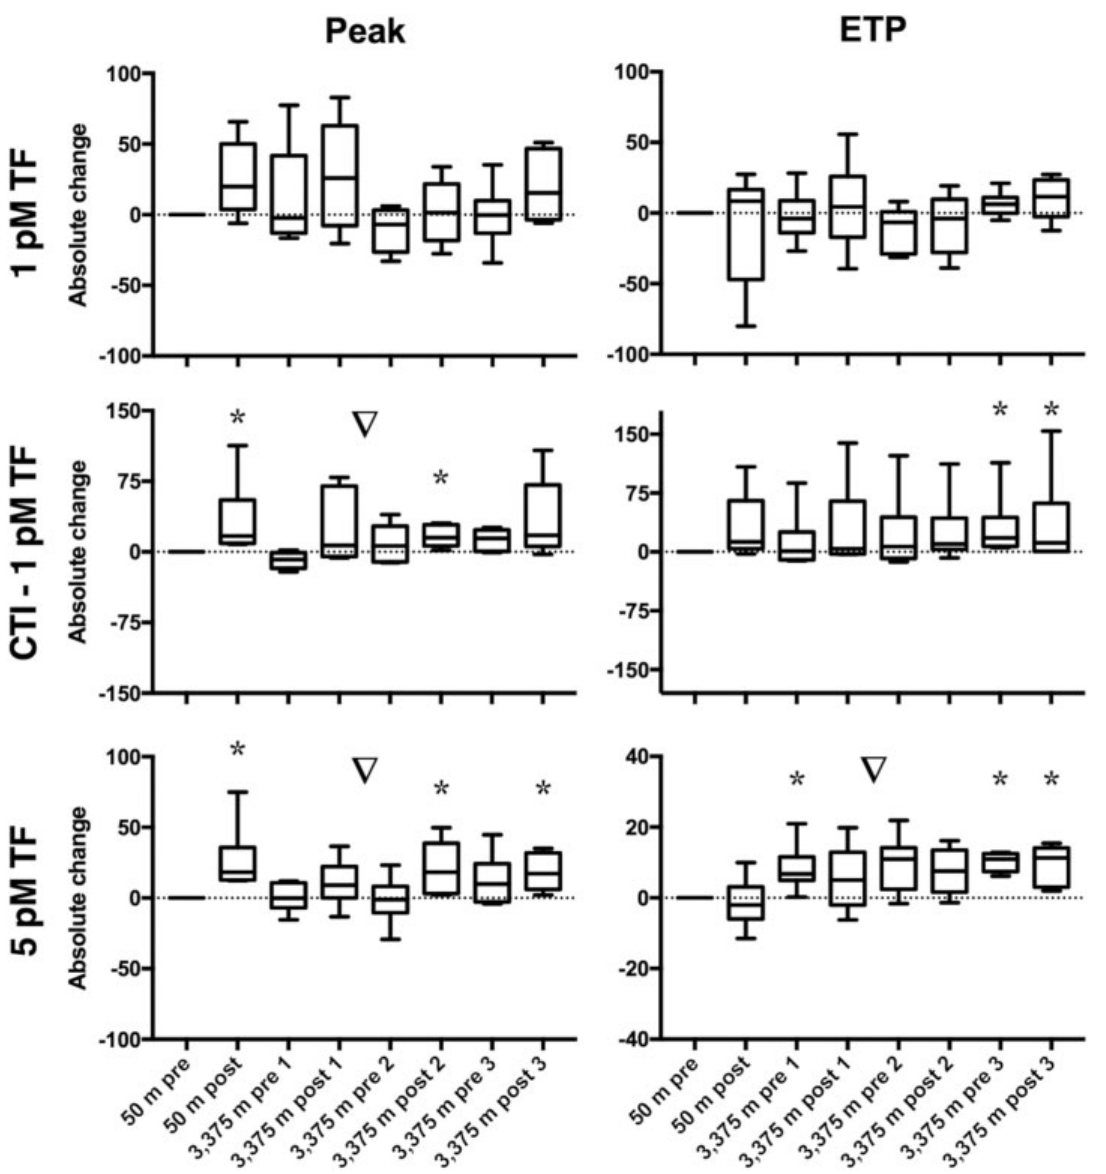
Fig. 4 In fl uence of normoxic and hypoxic exercises on thrombin generation (TG) in platelet-poor plasma (PPP). TG was measured before and after 2 hours of strenuous exercise, once at 50m altitude and three times at 3,375m altitude, in PPP with and without added corn trypsin inhibitor (CTI). Parameters derived from the TG curve are peak height (peak % of NPP) and endogenous thrombin potential (ETP in % of NPP). N ¼ 6, results are expressed as the absolute change of 50 m pre-exercise; a value above 0 indicates an increase, and a value below 0 indicates a decrease. 5 ¼ p < 0.05 (Friedman ’ s test); (cid:5) ¼ p < 0.05 compared with zero (Wilcoxon signed-rank